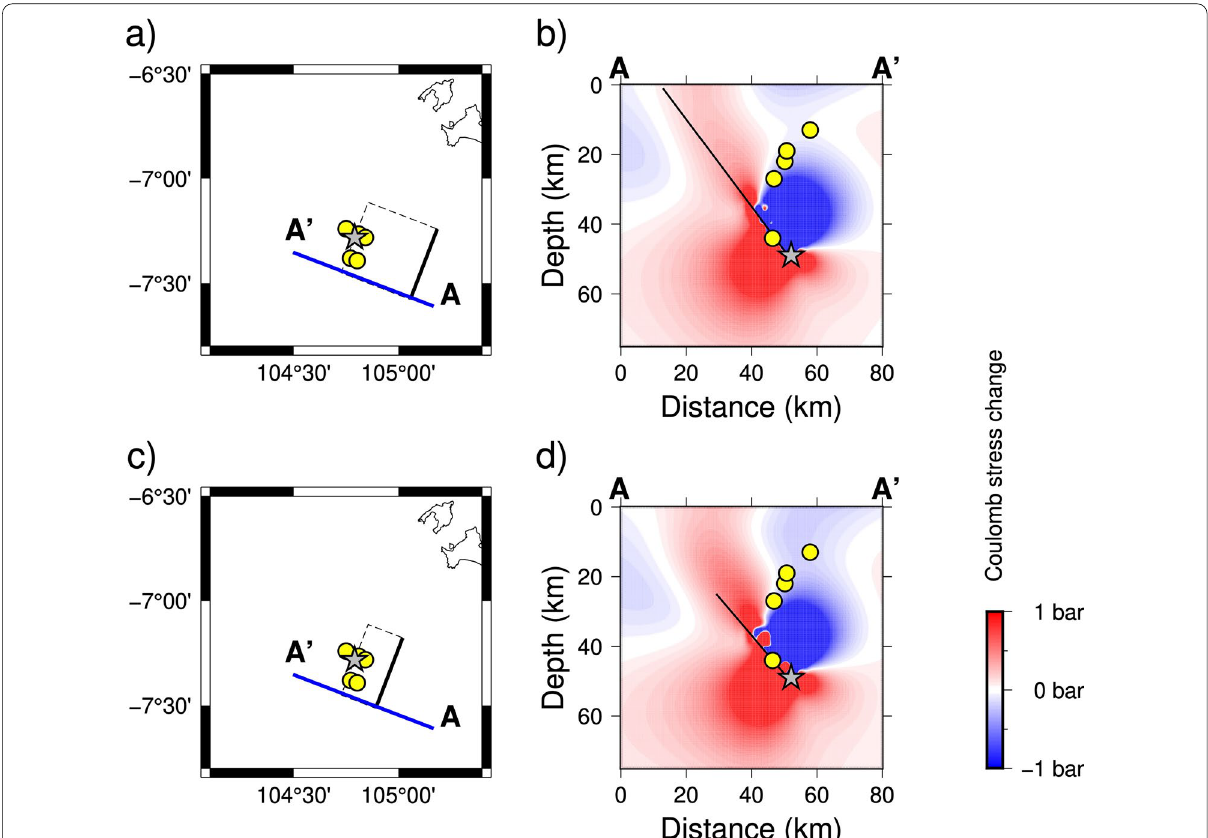
Fig. 11 Relocated aftershocks distribution from 3—16 August 2019 and Coulomb stress change analysis correspond with fault a , b Model 2A, c , d Model 2B. (See Fig. 10 for a detailed description of the figure